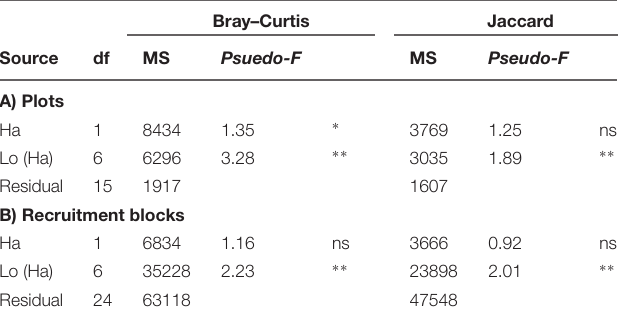
TABLE 1 | Permutational multivariate analysis of variance (perMANOVA) comparing environmental parameters (A) Temperature, (B) Salinity, (C) Dissolved Oxygen, (D) pH sampled at high tide from natural rocky shores and artificial seawalls.